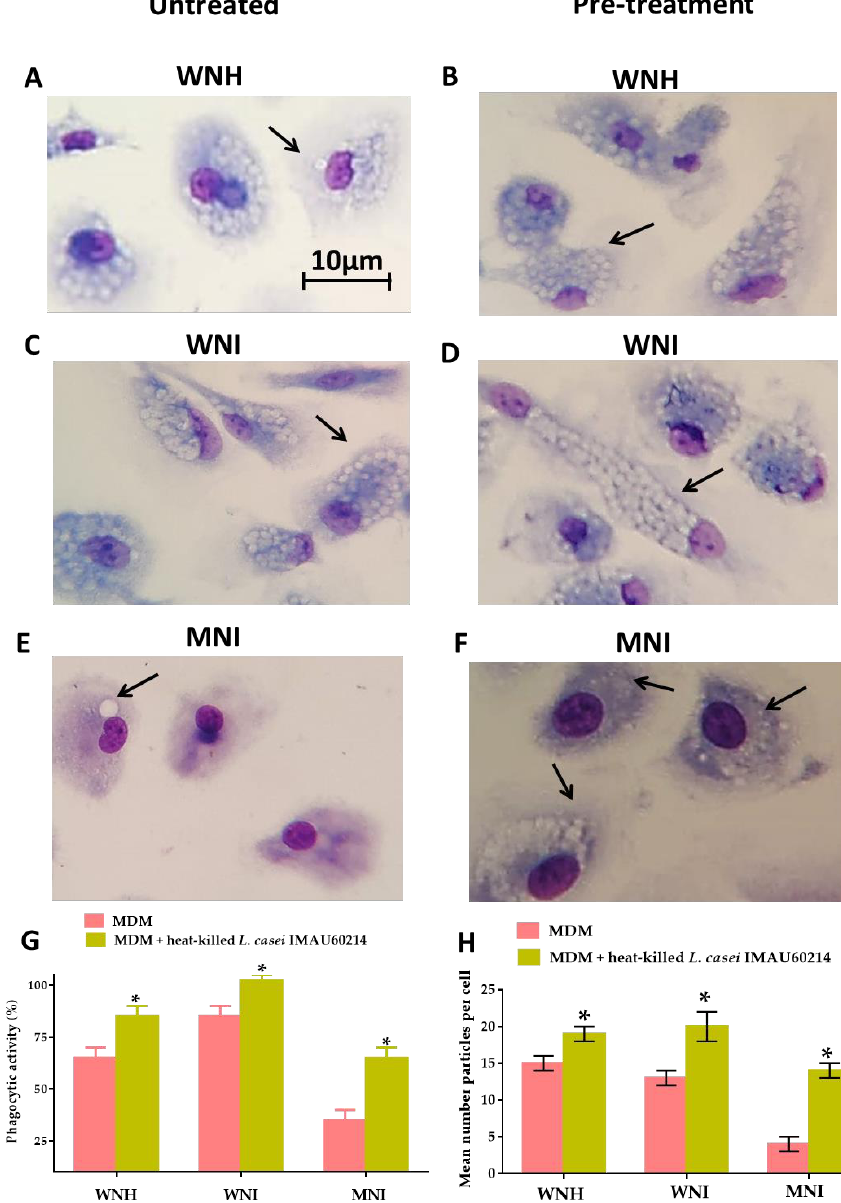
Figure 3. Heat-killed L. casei IMAU60214 increases the phagocytic function of MDM cells for WNH, WNI and MNI children. MDM cells were pretreated with heat-killed L. casei IMAU60214 at a ratio of 500:1 (Bacteria: MDM) for 24 h; zymosan was added to MDM cells at a ratio of 10:1. Representative photomicrographs show the phagocytosed zymosan by MDM cells. ( A ) WNH children untreated, ( B ) WNH children with pre-treatment, ( C ) WNI children untreated, ( D ) WNI children with pre-treatment, ( E ) MNI children untreated, ( F ) MNI children with pre-treatment. The arrow in panel ( A , C , E ) indicates an intracellular zymosan within the phagosome. The arrow in panel ( B , D , F ) shows the numerous vacuolations typically observed in activated MDM cells. ( G ) The percentage of phagocytic activity was calculated by the following formula: percentage phagocytic activity = number of MDM cells with zymosan internalized per 50 MDM cells, ( H ) mean amount of zymosan per cell. All values are shown as mean ± SD ( n = 15) from duplicate assays from MDM cells with and without pre-treatment with heat-killed L. casei IMAU60214. * p -Values were calculated with Student’s t paired test. * p < 0.05, significant difference.